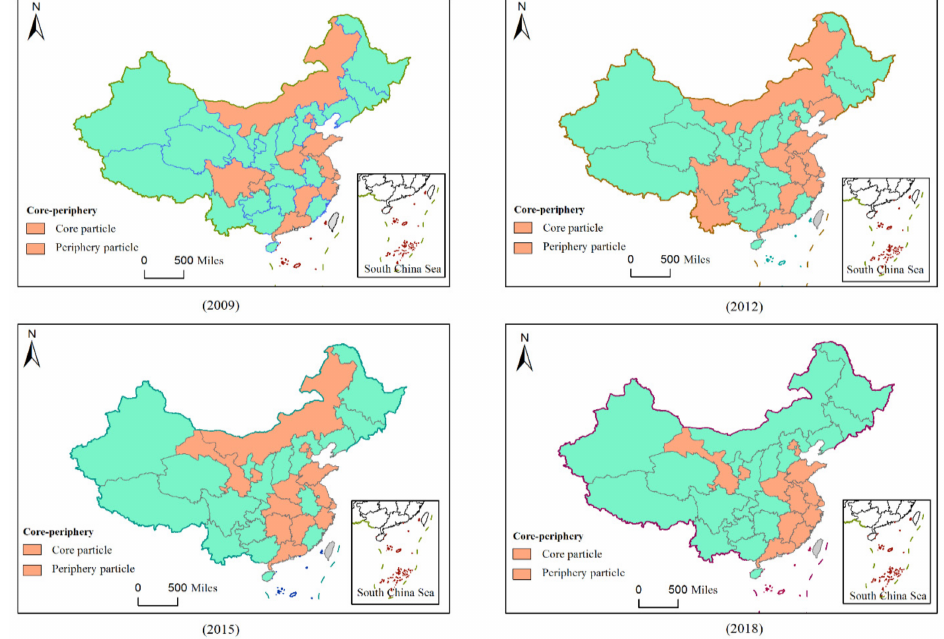
Figure 5. The core–periphery structure of the spatial correlation